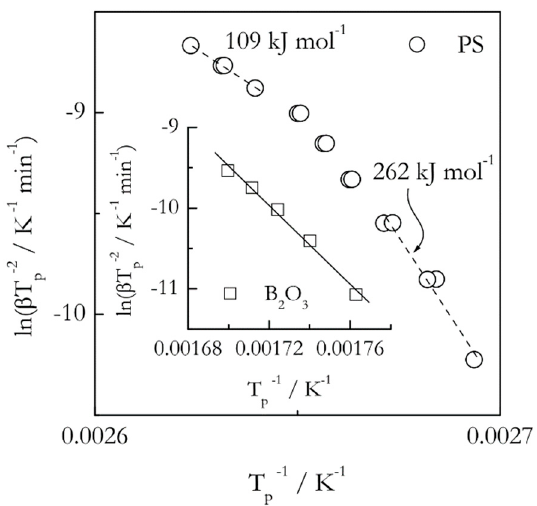
Figure 6. Kissinger plots for the glass transition in polystyrene (PS, circles) and boron oxide (B 2 O 3 , squares). For PS, the plot is visibly nonlinear, the activation energy decreases with temperature, the heating rate range 2.5–25 ◦ C min − 1 . For B 2 O 3 , the plot is practically linear, the activation energy is nearly constant, 203 ± 11 kJ mol − 1 , the heating rate range 5–25 ° C min − 1 . Data from Vyazovkin et al. [59,60].